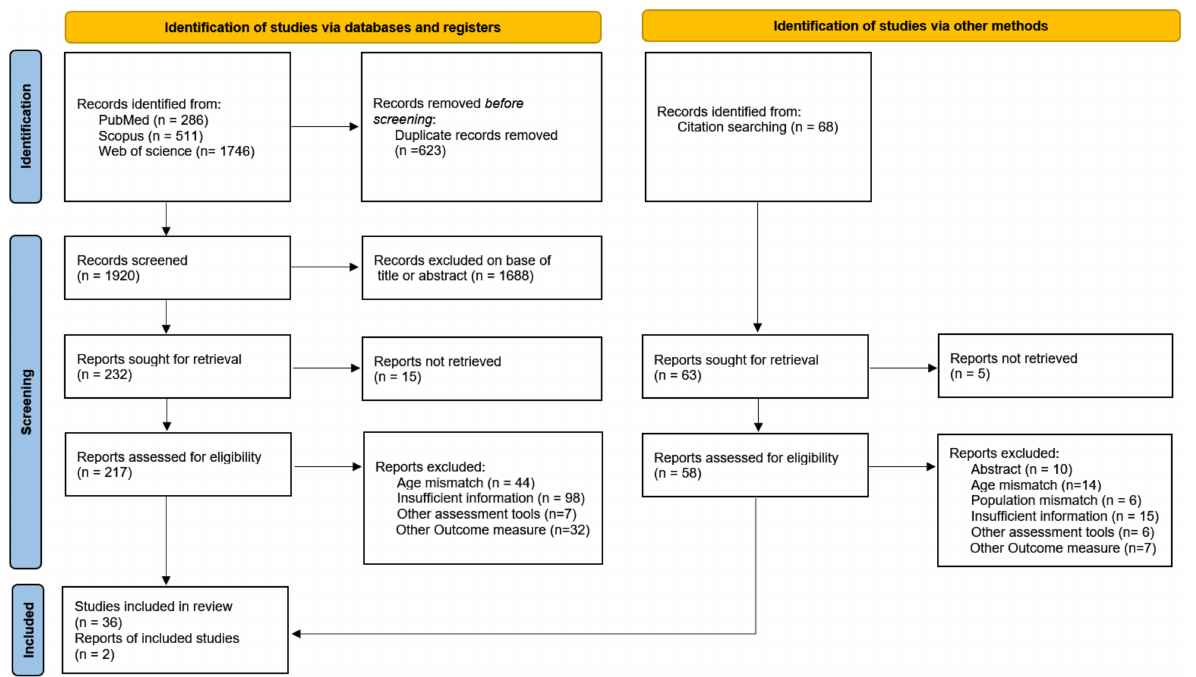
Figure 1. Flowchart of the study selection according to the Preferred Reporting Items for the System- atic Reviews and Meta-Analysis (PRISMA 2020)